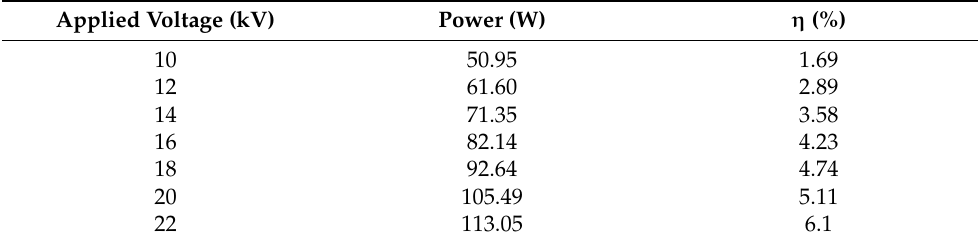
Table 3. The average consumed power and energy efficiency for different applied voltages.